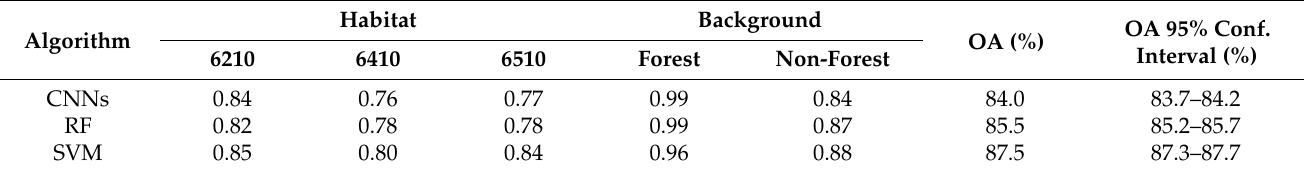
Table 4. Median F1 and overall accuracies calculated for each classifier